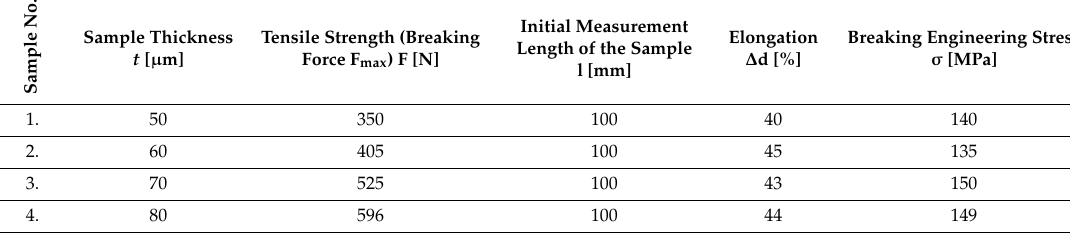
Table 2. Results of transverse tensile strength